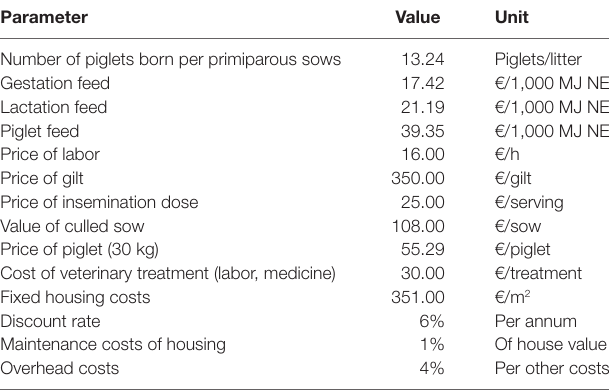
Table 3 | Price parameters used in the dynamic programming model. Parameter